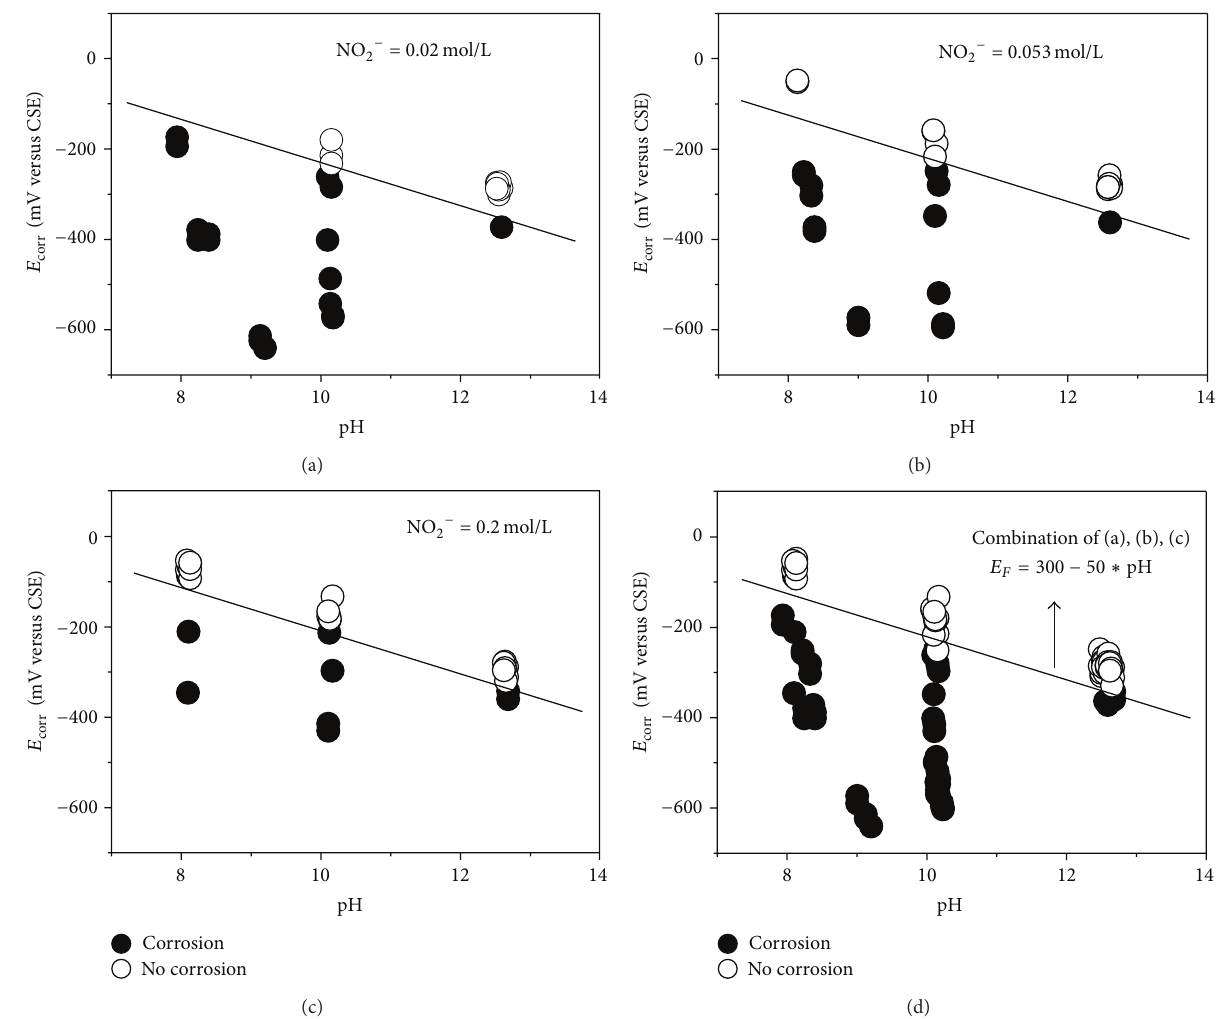
Figure 3: Relationship between 𝐸 𝐹 and pH for sulfate-induced corrosion. (a) NO 2− = 0.02 mol/L, (b) NO 2− = 0.053 mol/L, (c) NO 2− = 0.2 mol/L, and (d) combination of (a), (b), and